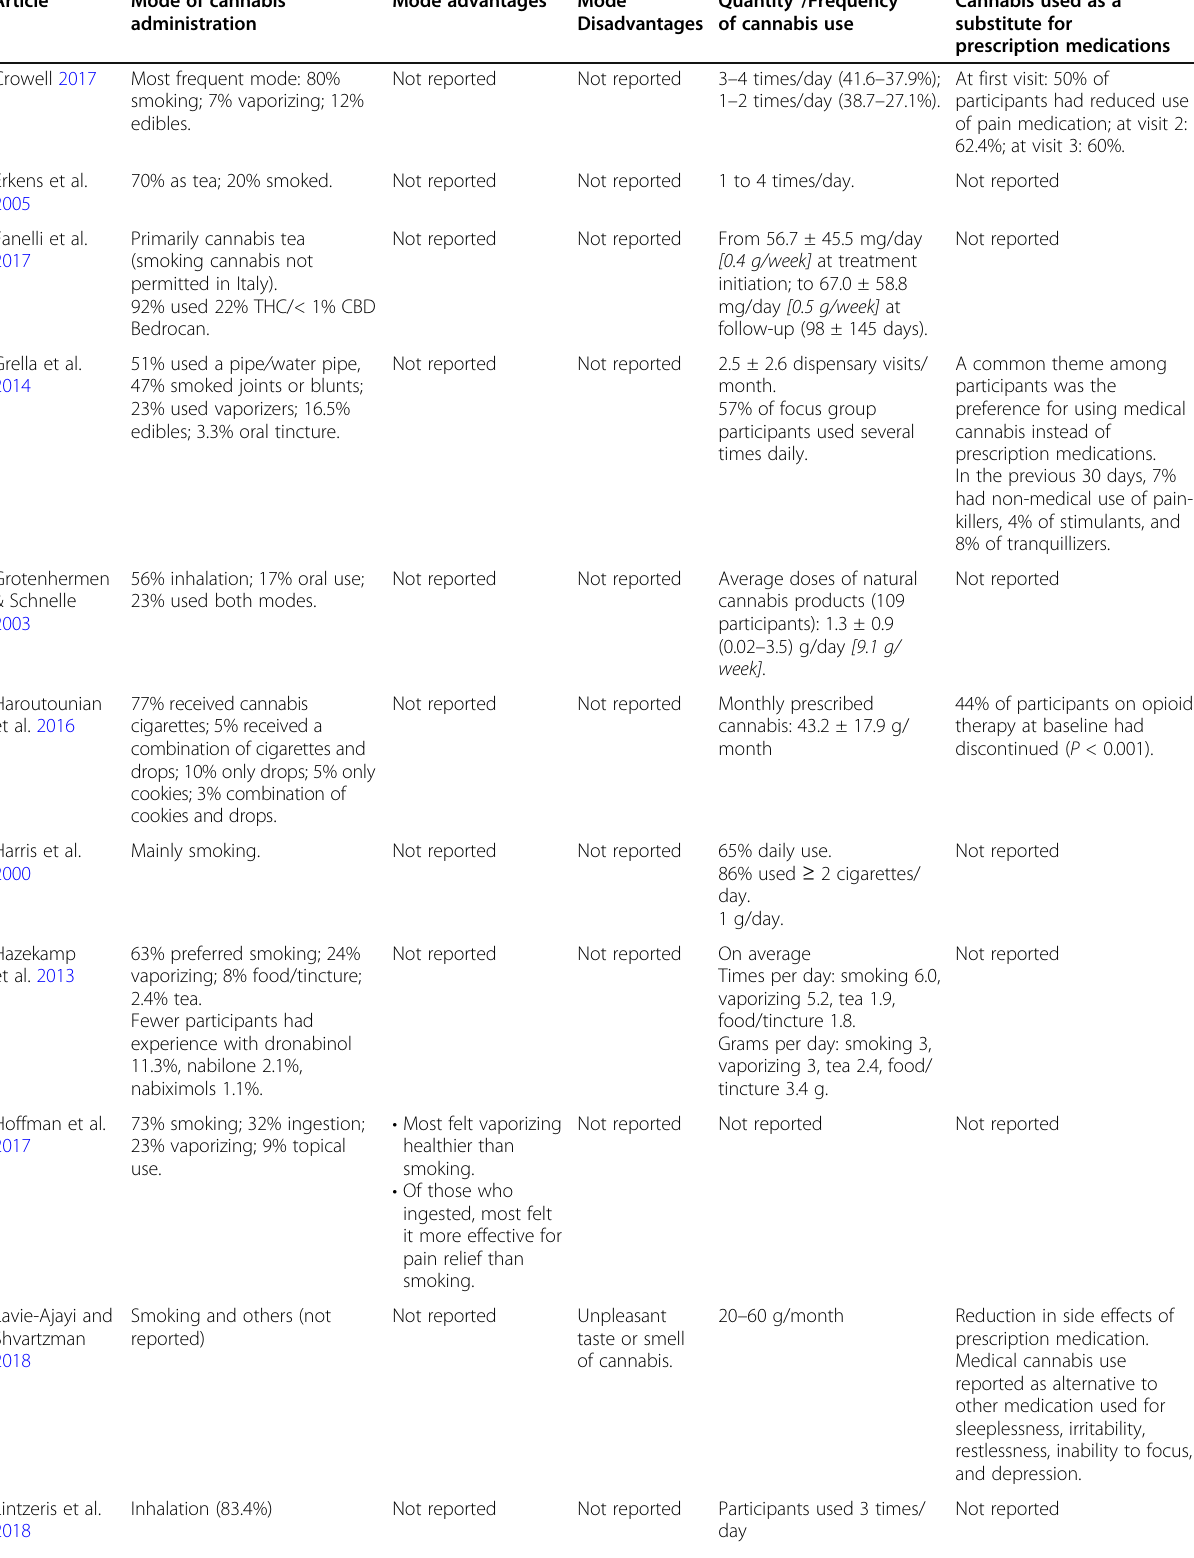
Table 2 Patterns of medical cannabis use and utilization of medical cannabis as a substitute for prescription medications